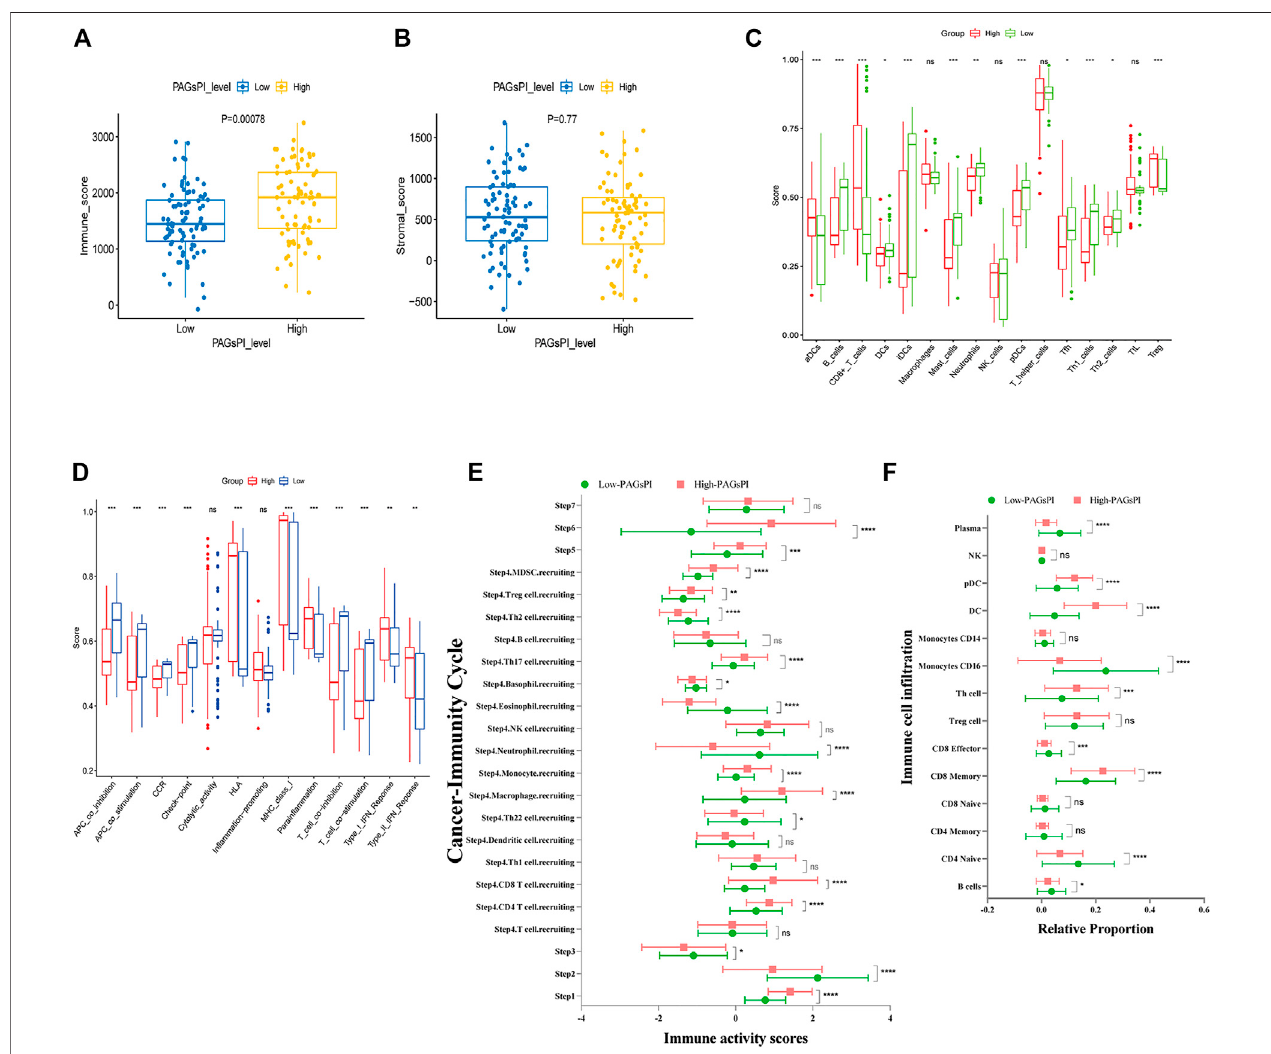
FIGURE4| ImmuneanalysisofthePAGsPIsubgroup. (A) ComparisonoftheimmunescoreinthePAGsPIsubgroupbyESTIMATE. (B) Comparisonofthestromal score in the PAGsPI subgroup by ESTIMATE. (C) Analyzing the types of immune cell in fi ltration in the PAGsPI subgroup by ssGSEA. (D) Immune-associated pathways by ssGSEA. (E) Pro fi ling the status of anti-cancer immunity across seven-step Cancer-Immunity Cycle by TIP. (F) Analyzing the types of immune cell in fi ltration in the PAGsPI subgroup by TIP.